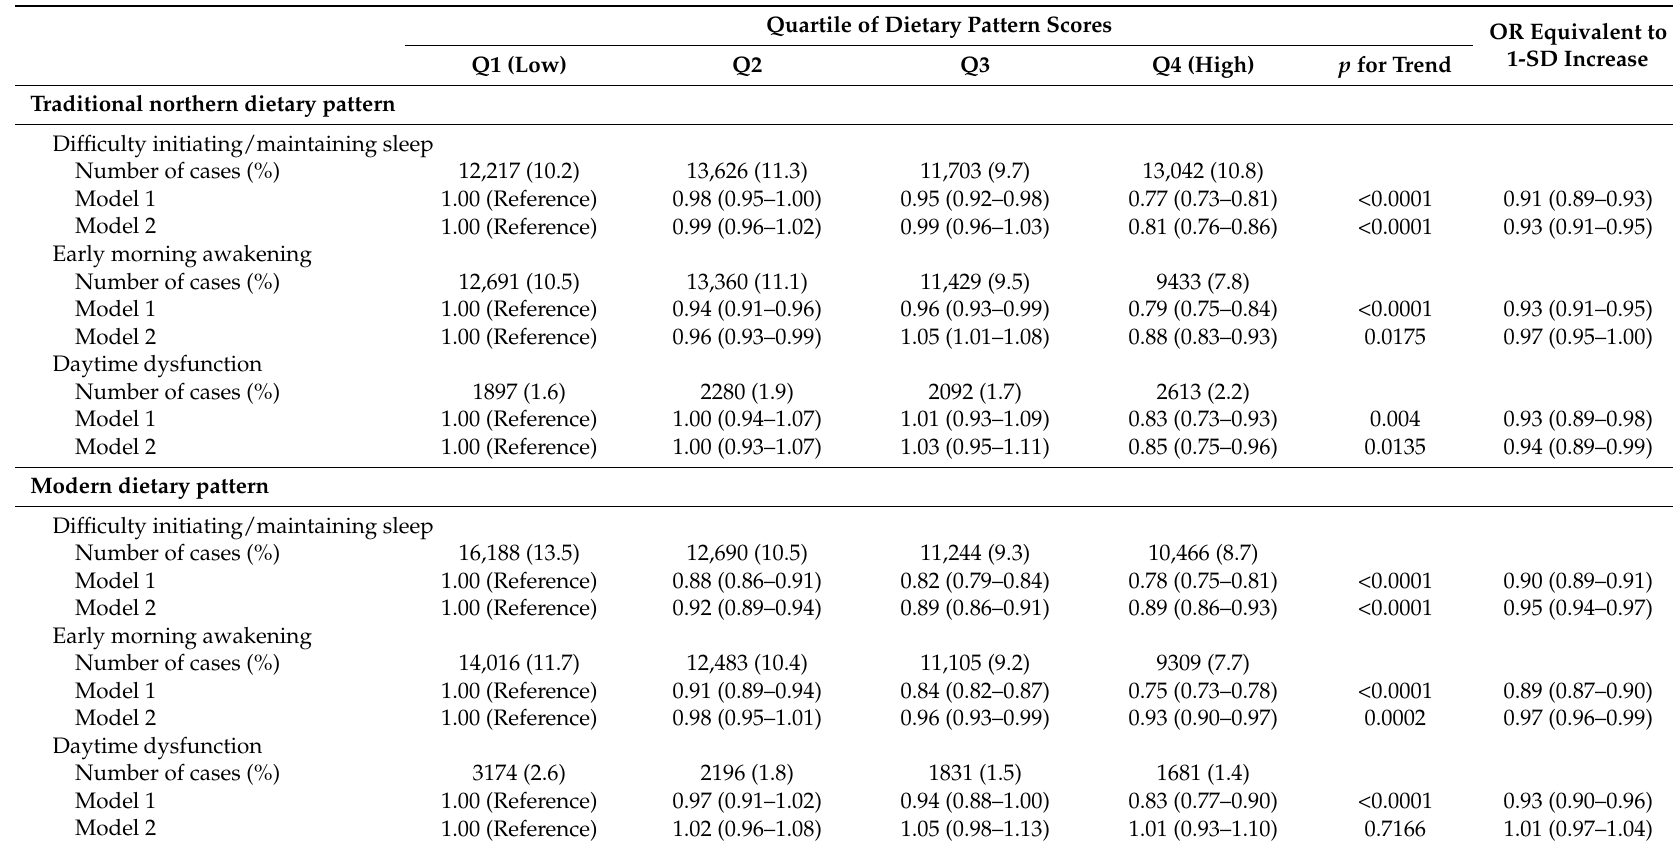
Table 3. Odds ratios and 95% confidence interval of sleep problems by quartile of dietary pattern score. Quartile of Dietary Pattern Scores OR Equivalent to